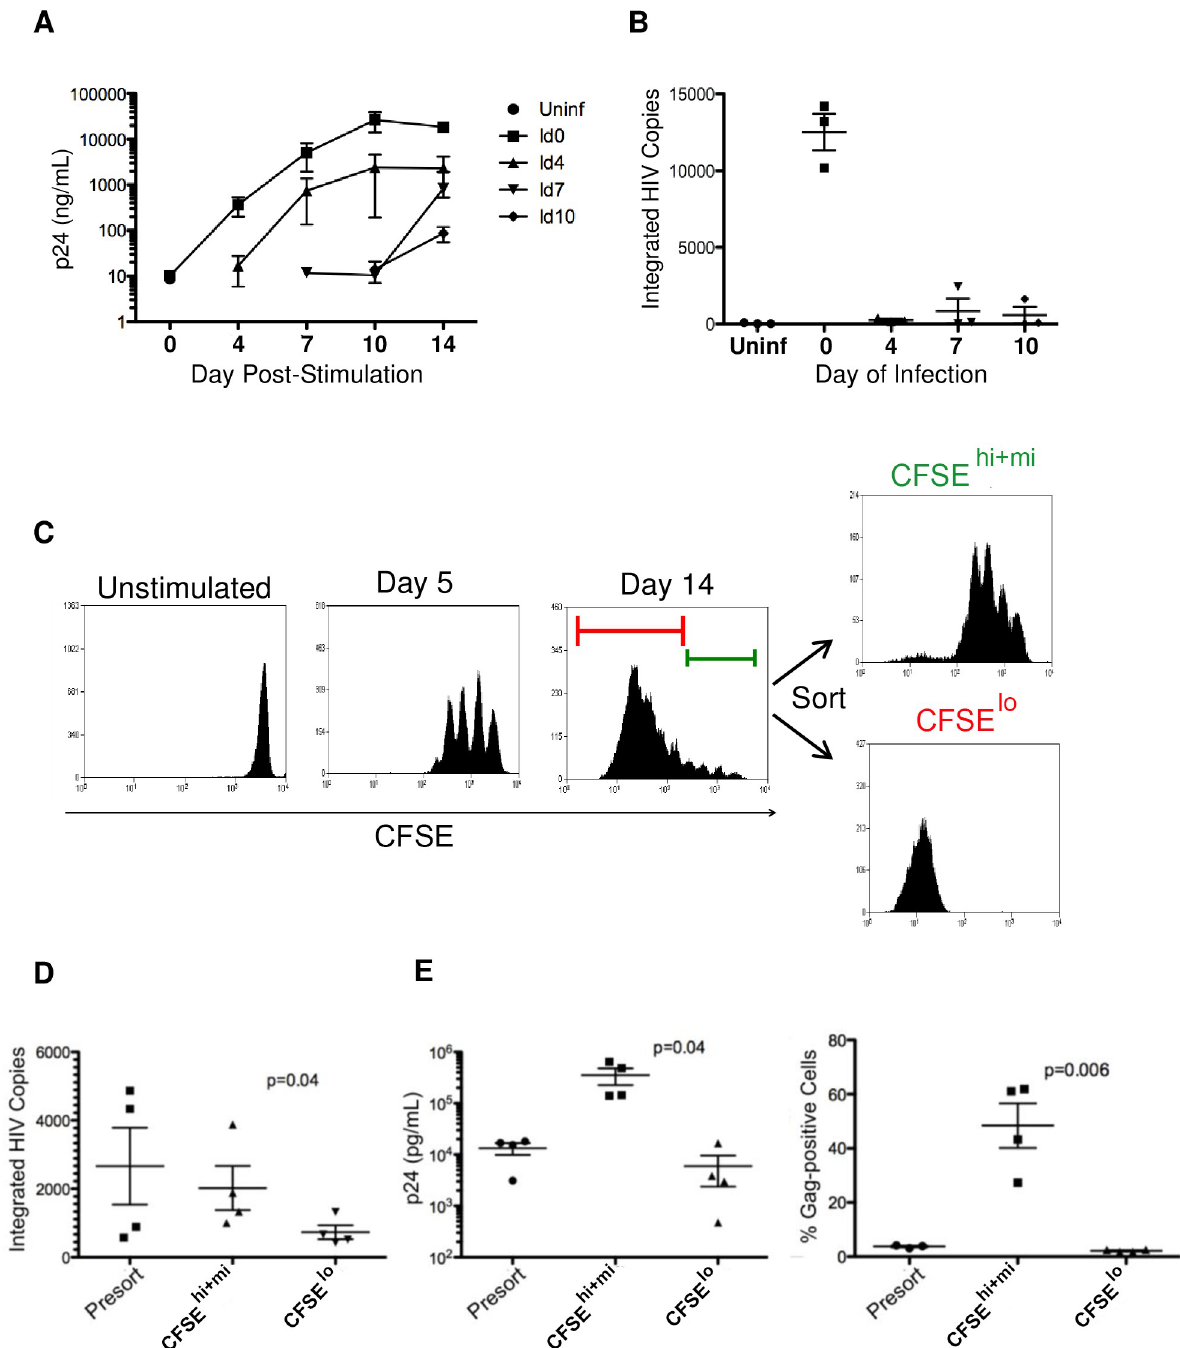
Fig 3. Cell stimulation status at the time of infection and the amount of cell proliferation following infection impact the establishment of HIV latency. Aliquots of freshly isolated primary CD4 T cells were infected with HIV at different time points relative to the addition of activated stimulus: before (day 0) or following (days 4, 7, 10) initial TCR stimulation. Antiretroviral drugs were not added to culture in these experiments. (A) Productive virus replication, following infection at varying time points after cell stimulation (day 4) was monitored sequentially over time in culture (days 0 to 14) for the levels of secreted p24 production by ELISA analysis. (B) Cell aliquots were taken at the end of culture (day 14), to extract genomic DNA and perform qPCR analysis for the quantification of integrated HIV DNA copies. Sample legend (A and B) for time of HIV infection relative to the addition of activation stimulus: uninfected control, Uninf; infected on day 0, Id0; on day 4, Id4; on day 7, Id7; on day 10, Id10. Data shown (A and B) represent the mean ± SEM from 3 independent experiments, using cells from different donors. In a separate set of cell-sorting experiments (C, D and E), our standard 14-day cell model of HIV latency (Fig 1A) was used to examine the influence of infected cell proliferation on